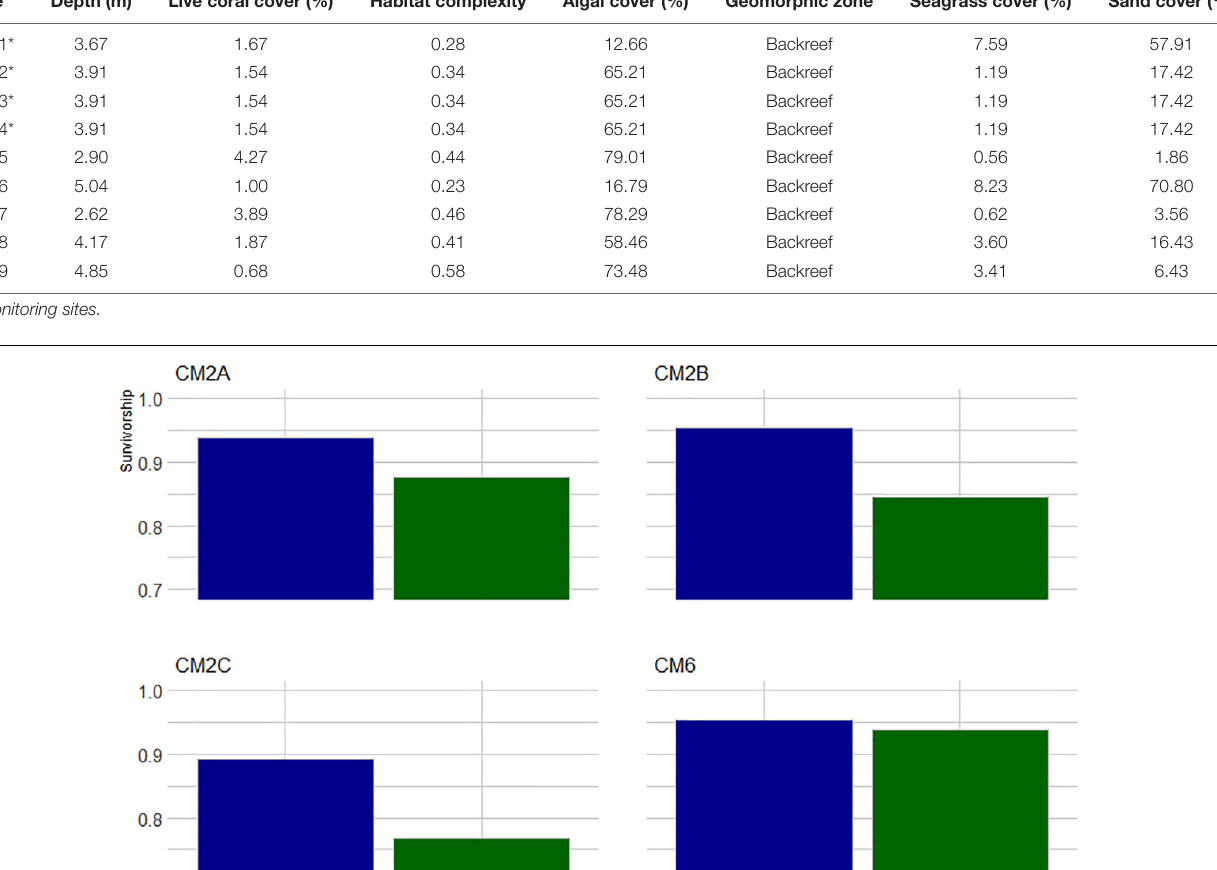
Geomorphic zone Seagrass cover